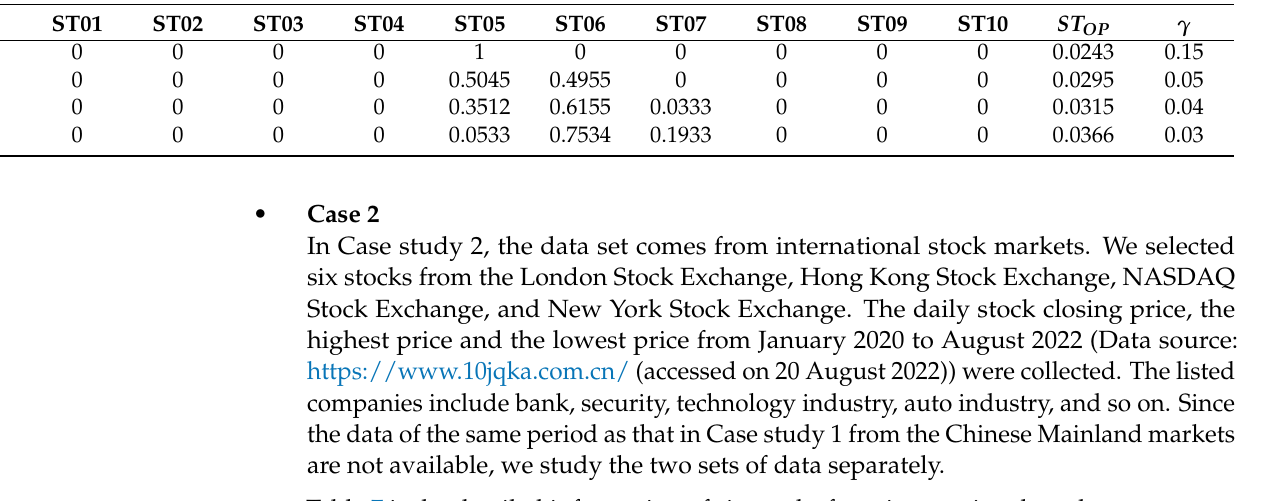
Table 7 is the detailed information of six stocks from international markets. Table 7. International Sample